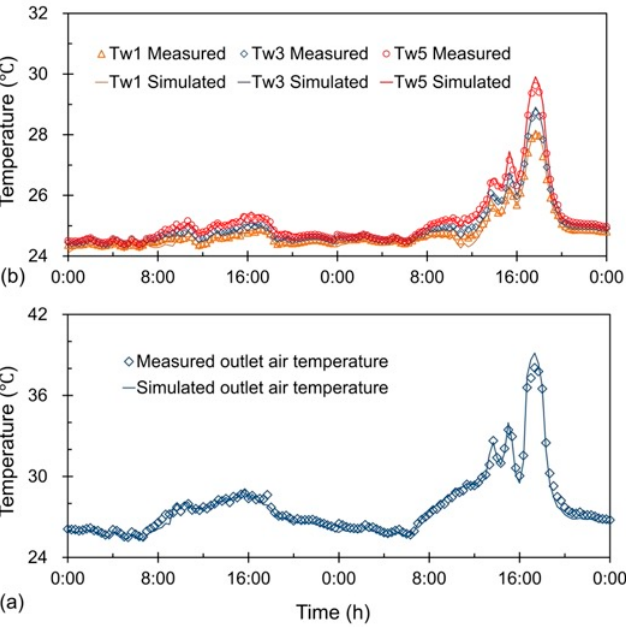
8 of 18 Figure 4. Layout of the measurement facilities [35].